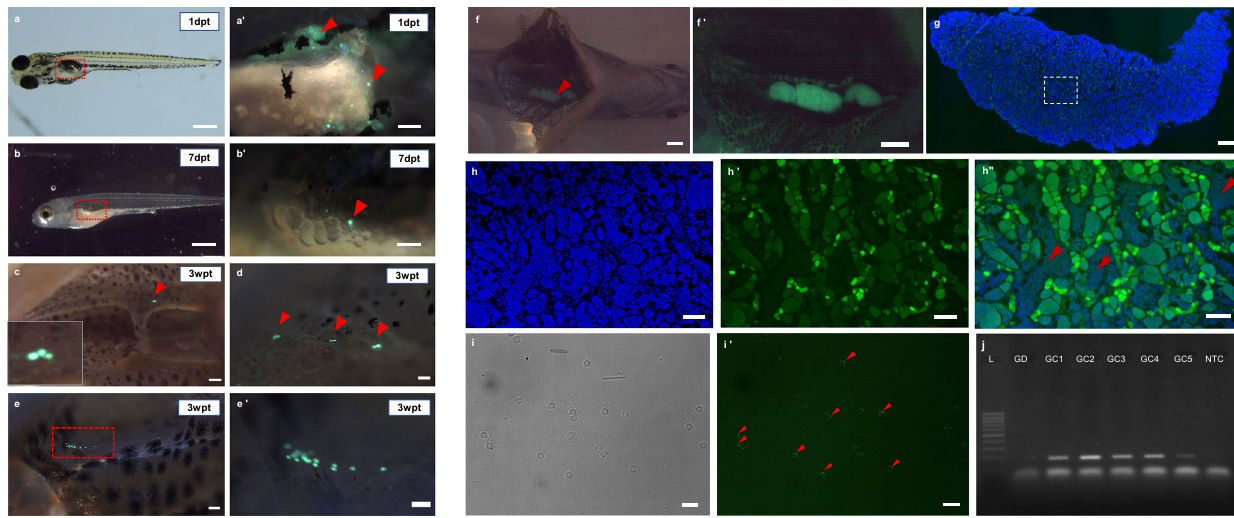
Fig. 3 Intra-peritoneal spermatogonium transplant from Tg(ddx4:egfp) zebra fi sh into sterile giant danio recipients. a-a ’ Detection of GFP-positive cells under fl uorescence immediately after transplant into the posterior part of the gas bladder ( n = 100). The magni fi ed area is the red dashed rectangle, and cells are indicated by red arrowheads. b , b ’ The number of transplanted cells decreased seven days post-transplant, possibly because damaged spermatogonia and other cells, such as spermatids, are degraded over time, and few germ cells survive to proliferate. Eighty- fi ve survived recipients were analyzed at 7dpt. c , d Two dissected recipients three weeks post-transplant (3wpt) show few GFP-positive cells in the genital ridge. e Another recipient of the same age group shows a cluster of cells indicated by a red dashed rectangle. Higher magni fi cation e ’ . A total of fi ve recipients were analyzed at 3wpt. f One fi ve-month-old degutted germline chimera shows the presence of unilaterally developed testis under fl uorescence microscope (FITC fi lter), and the red arrowhead indicates the testis. f ’ Higher magni fi cation of the testis. g Longitudinal section of the same testis (merged image, the blue color is DAPI, and the green color is for GFP expression). h Higher magni fi cation of the region depicted by the white rectangle from image g , under the DAPI fi lter, h ’ The same region under the FITC fi ler shows the expression of Vasa. h ” Merge image for DAPI and FITC, and the red arrowheads indicate the spermatozoa populations. Approximately twenty sections were analyzed to check the Vasa expression i , i ’ Sperm from the germline chimera ( n = 5) under bright fi eld and the GFP expression of the residual Vasa protein near the midpiece of the spermatozoa (indicated by red arrowheads) under the FITC fi lter. j The gel image of the fi ve germline chimera (GC1-GC5) shows positive ampli fi cation for the GFP gene, and the product length is 187 bp loaded on 1.5% agarose gel. GD- sperm from giant danio males shows no PCR ampli fi cation, L-100bp DNA marker, and NTC is no template control. Uncropped and unedited gel image for this fi gure is provided as Supplementary Fig. 2. Filter used DA/FI/TRITC ( a ’ , b ’ , c , d, e , and e ’ ) and bright fi eld ( a , b ). dpt – day post-transplant, wpt – week post-transplant. Scale bars: a , b , f , and f ’ = 1 mm, b ’ , a ’ , c , d , e , e ’ , h and h ” = 100 µ m, g = 200 µ m, i and i ’ = 10 µ